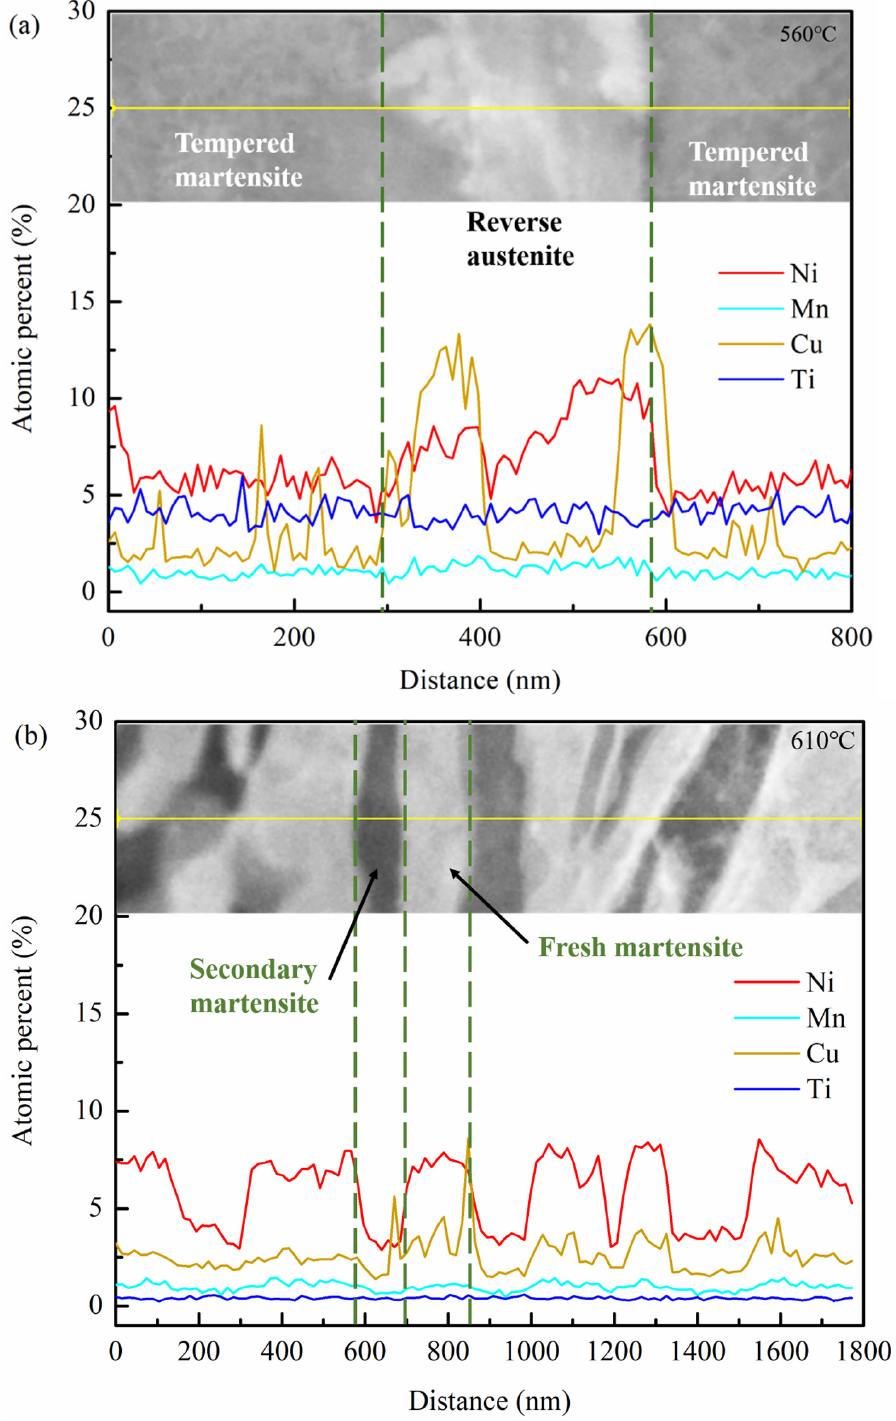
Figure 9. STEM image analysis after tempering at different temperatures. ( a ) 560 °C; ( b ) 610 °C.